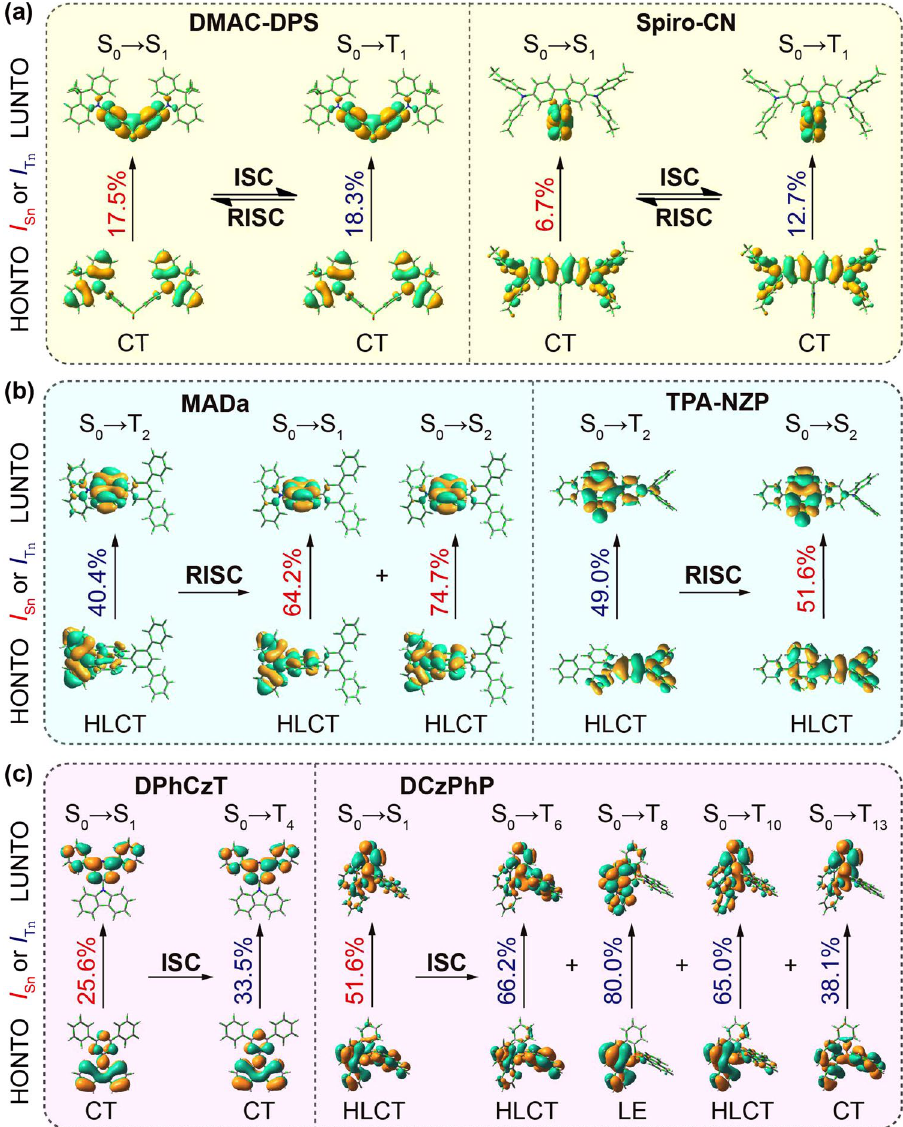
Figure 5. HONTO and LUNTO distributions and overlap extents of the singlet (S n ) and triplet (T m ) states for exciton transformation in ( a ) TADF, ( b ) HLCT and ( c ) OURTP